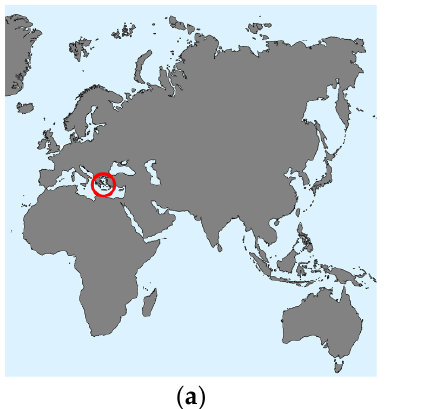
Figure 11. ( a ) Location of Greece. ( b ) Location of Athens.